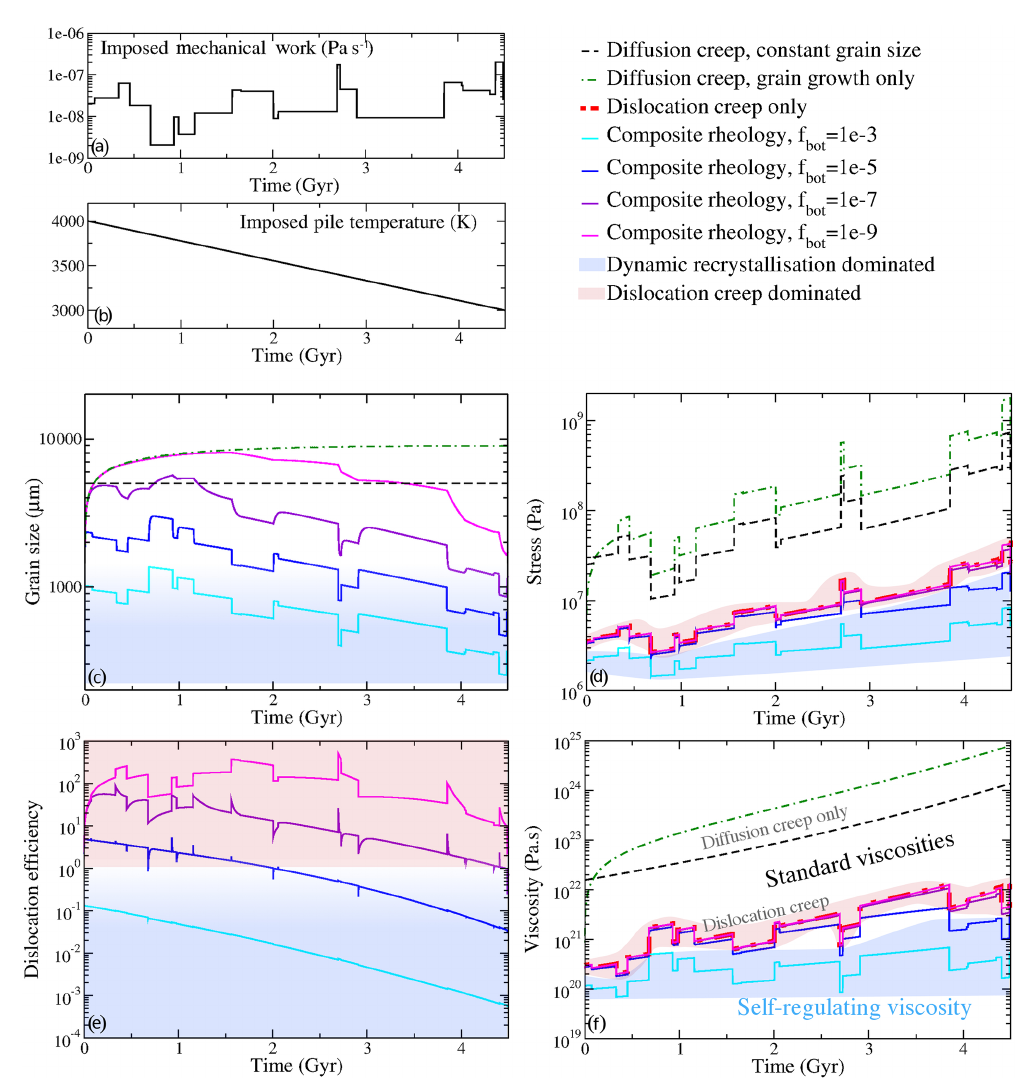
Figure 8. Several possible scenarios for the evolution of grain size, stress, dislocation efficiency and viscosity applied to the history of the Earth. Panels (a, b) show our assumptions for the evolution of temperature (constant cooling) and mechanical work (randomised). Panels (c– f) show the impact of different grain size evolution models on the rheology of the thermochemical piles throughout cooling and chaotic convection. (c) shows the evolution of grain size, (d) represents the evolution of stress, (e) depicts the dislocation efficiency (the ratio of diffusion over dislocation creep viscosities) and (f) illustrates the viscosity as a function of